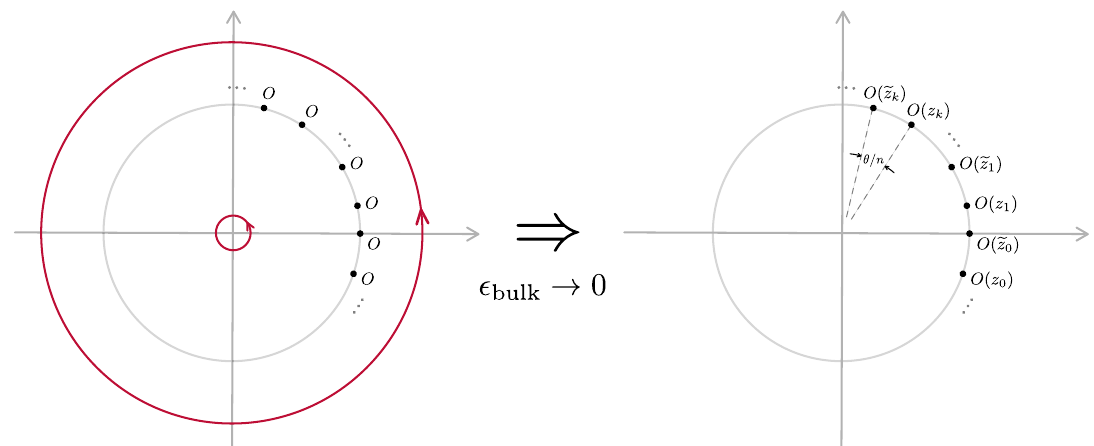
Figure 6: Left : The bulk geometry at finite β . The inner red circle is the tube around the entanglement cut and is identified with the outer red circle. The operator inser- tions are indicated with black dots. Right : The bulk geometry in the limit β → 0 or → 0. The inner circle has now shrunk to a point and the geometry equivalently ε bulk has become the two-dimensional plane. The operators are now situated along the z unit circle. The coordinates z and are given in (cid:101) i i